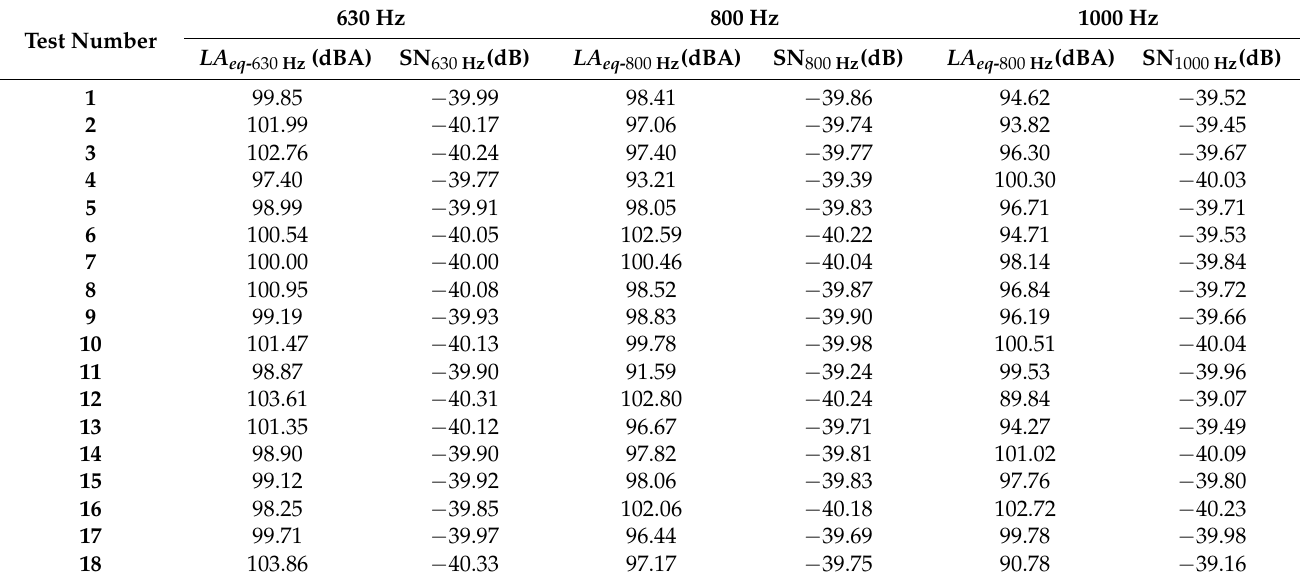
Table 4. Numerical results of the LA eq and the corresponding SN